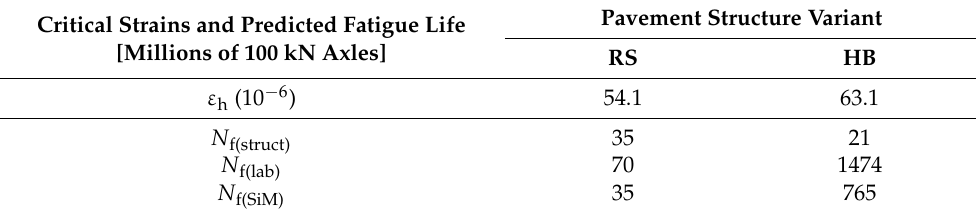
Table 7. Design life of the pavement structures analyzed in the work, determined using formula (1) and coefficients given in Table